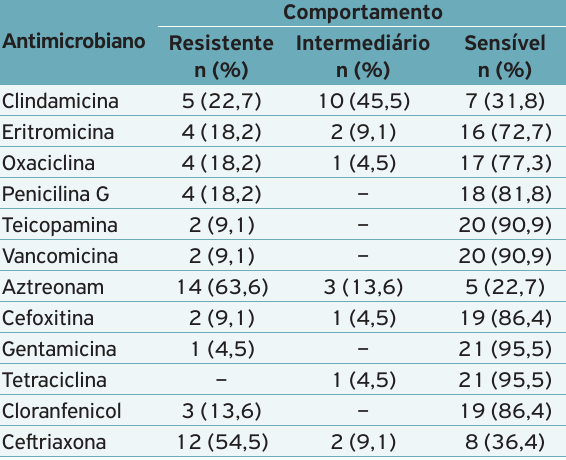
Tabela 1. Comportamento das espécies de Listeria isoladas de carpaccio, frente aos agentes antimicrobianos.